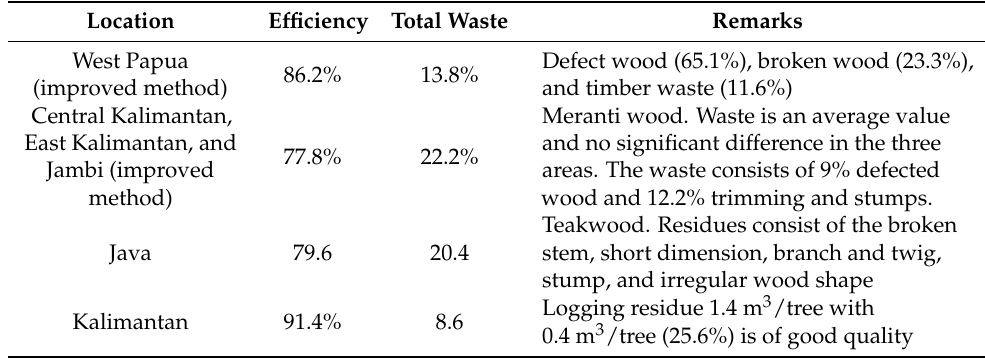
Table 1. Wood harvesting efficiency using the improved method in Indonesia (in %).